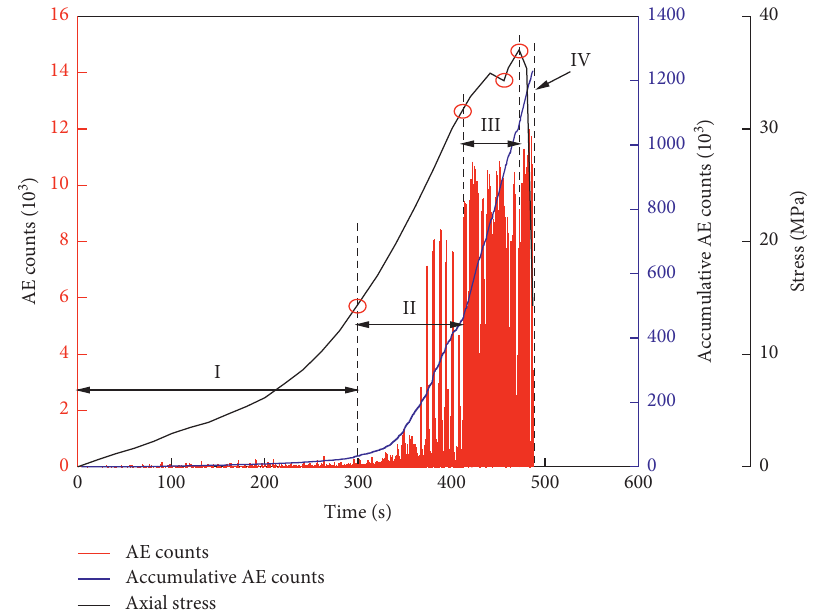
Figure 15: AE counts and accumulative AE counts of the jointed specimens with α � 90 ° .